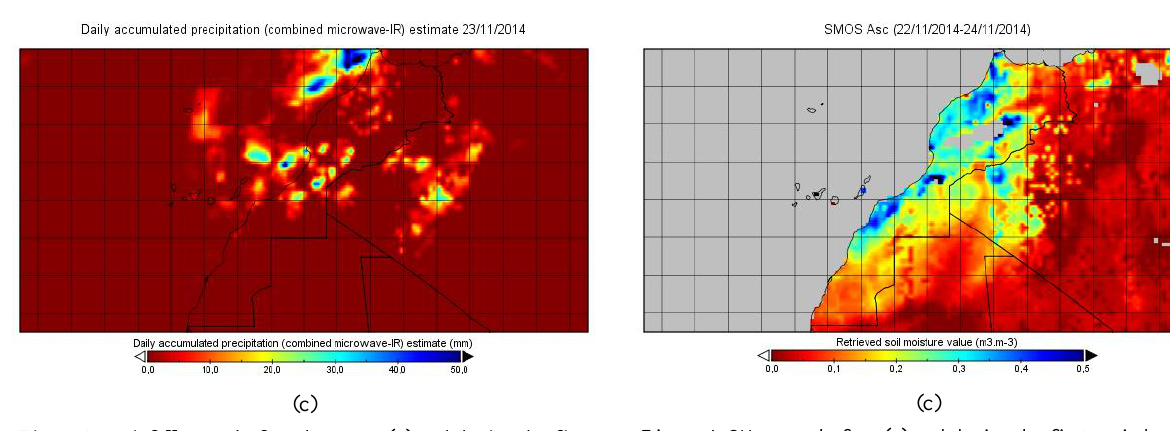
Figure 4. SM maps before (a) and during the first period of rain Figure 3. Rainfall maps before the event (a) and during the first period of rain (b), (c).